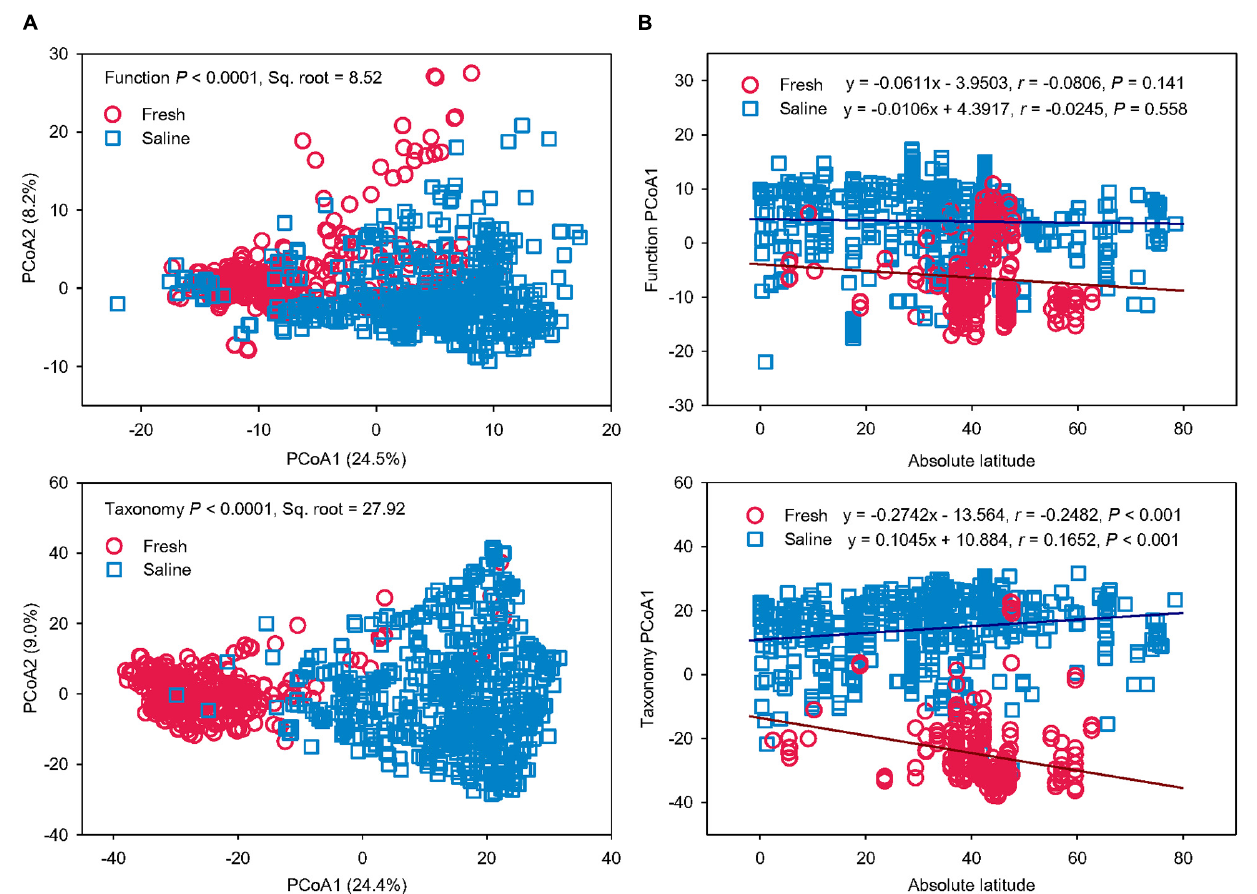
FIGURE 4 | Salinity drives microbial functional and taxonomic diversities. (A) Principal coordinates analysis (PCoA) showing beta-diversity of microbial functional and taxonomic diversities between fresh vs. saline water metagenomes annotated in Subsystems L3 (Function) and RefSeq at the genus level (Taxonomy). The error bars represent the standard deviation of data ranges. Variations explained by two principal coordinate dimensions are given in parentheses by percentage. P values and Sq. root of PERMANOVA are also given. (B) Pearson’s correlations of the absolute latitude of water metagenome locations with principal coordinate (PCoA) 1 scores of Bray-Curtis similarity of fresh vs. saline water metagenomes annotated in Subsystems L3 (Function) and RefSeq at the genus level (Taxonomy). Regression equations, coefficients ( r ), and P values are given. The linear regression lines of fresh and saline water metagenomes were shown as the brown and blue solid lines,